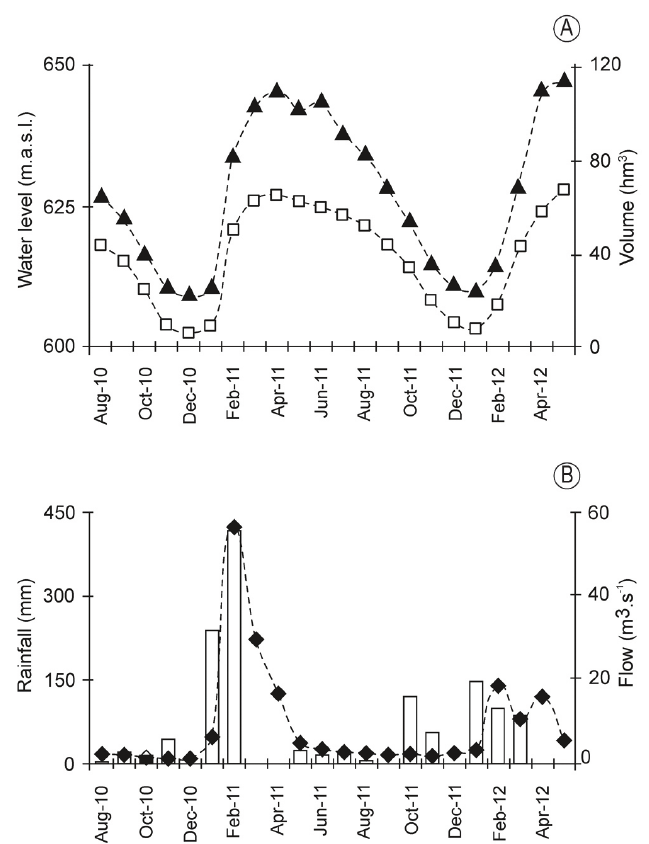
Figure 2. A- B. A. Fluctuation in water level (m.a.s.l.) ( □ ) and volume (hm 3 ) ( ▲ ); B. Variation in the rainfall (mm) (in bars) and water contribution (m 3 .s –1 ) (line). Table 2. Correlation matrix of variables with ** p<0.01, * p<0.05 significance levels. Depth